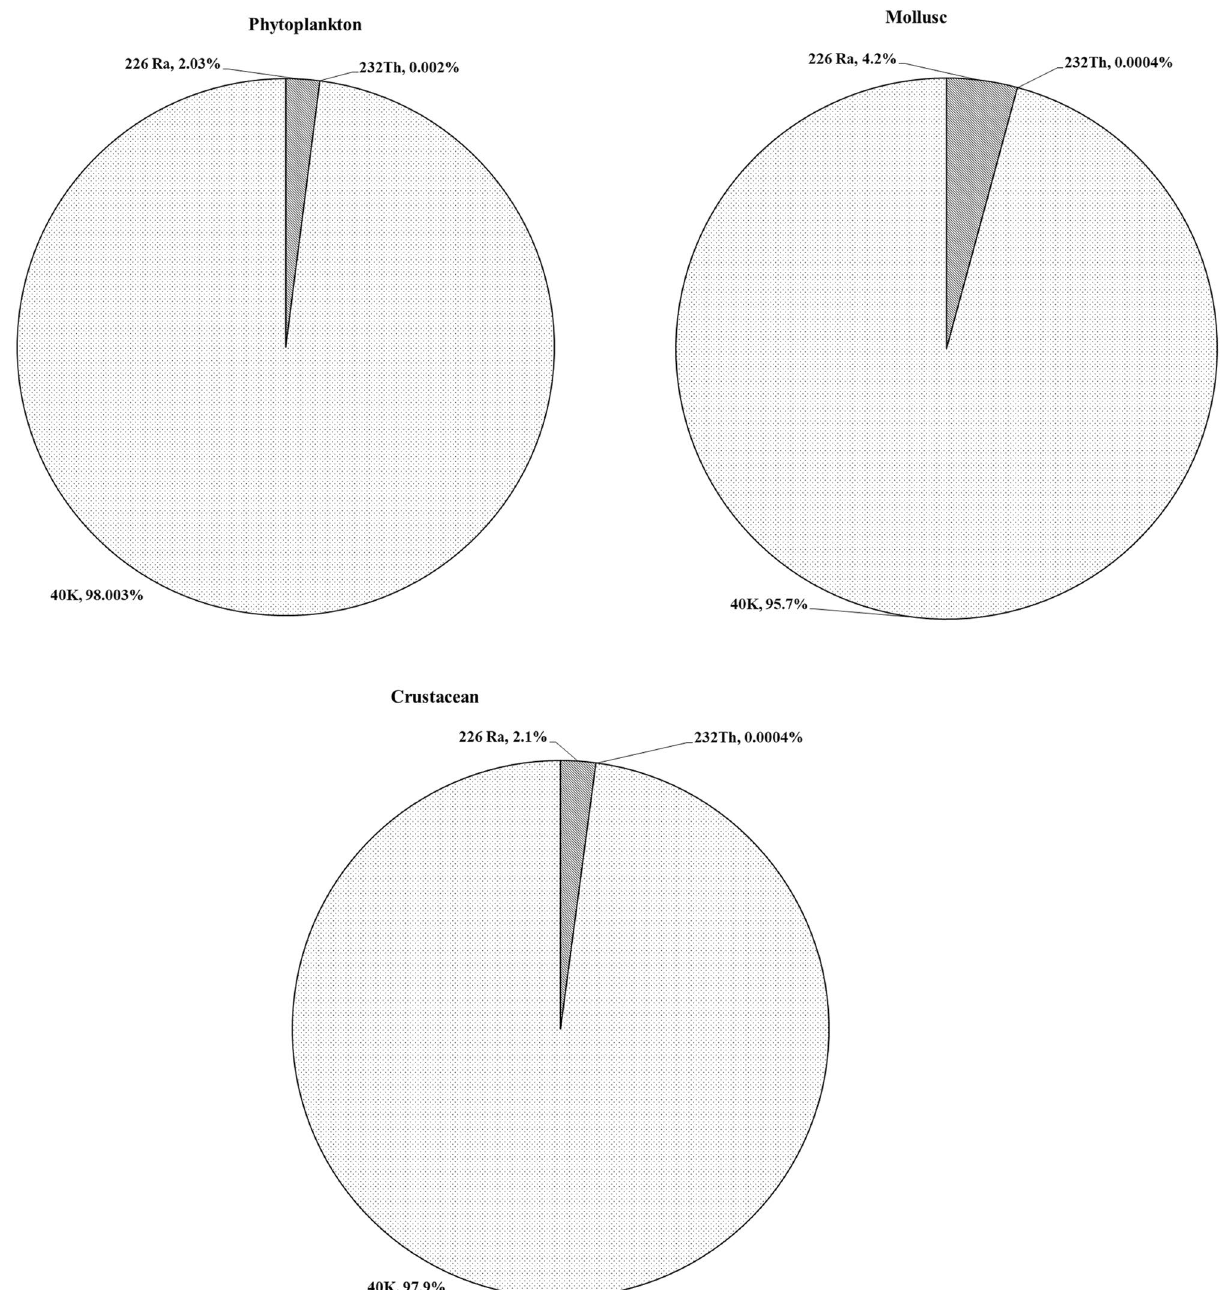
Figure 5. Percentage contribution of natural radionuclides to the external dose of aquatic